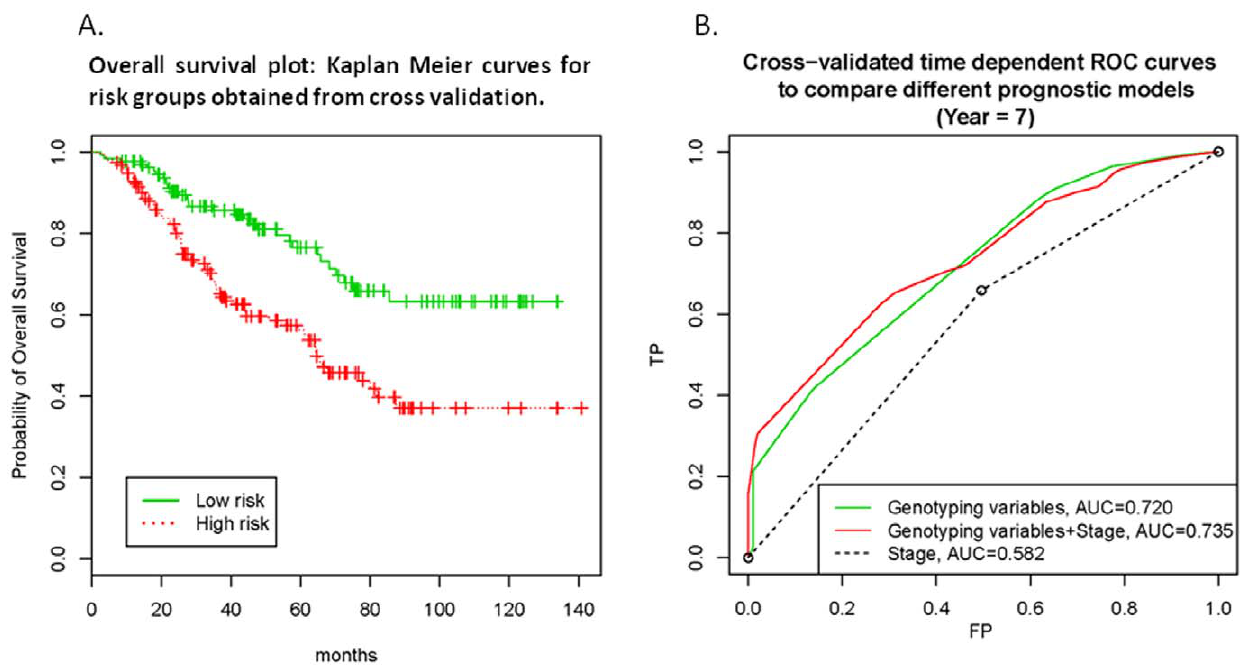
Figure 3. Multivariate Cox regression analysis with stage as a factor. LOOCV Kaplan-Meier curve (Figure 3A) showed that 131 patients (31 deaths) were in the low risk group (green line) and 153 patients (69 deaths) were in the high risk group (red line). The Leave-One-Out Cross Validated time dependent (7 year) ROC curves (Figure 3B) to compare different prognostic models: Stage only (dashed line); Stage and five-marker genotyping signature (red line); Five-marker genotyping signature only (green line).